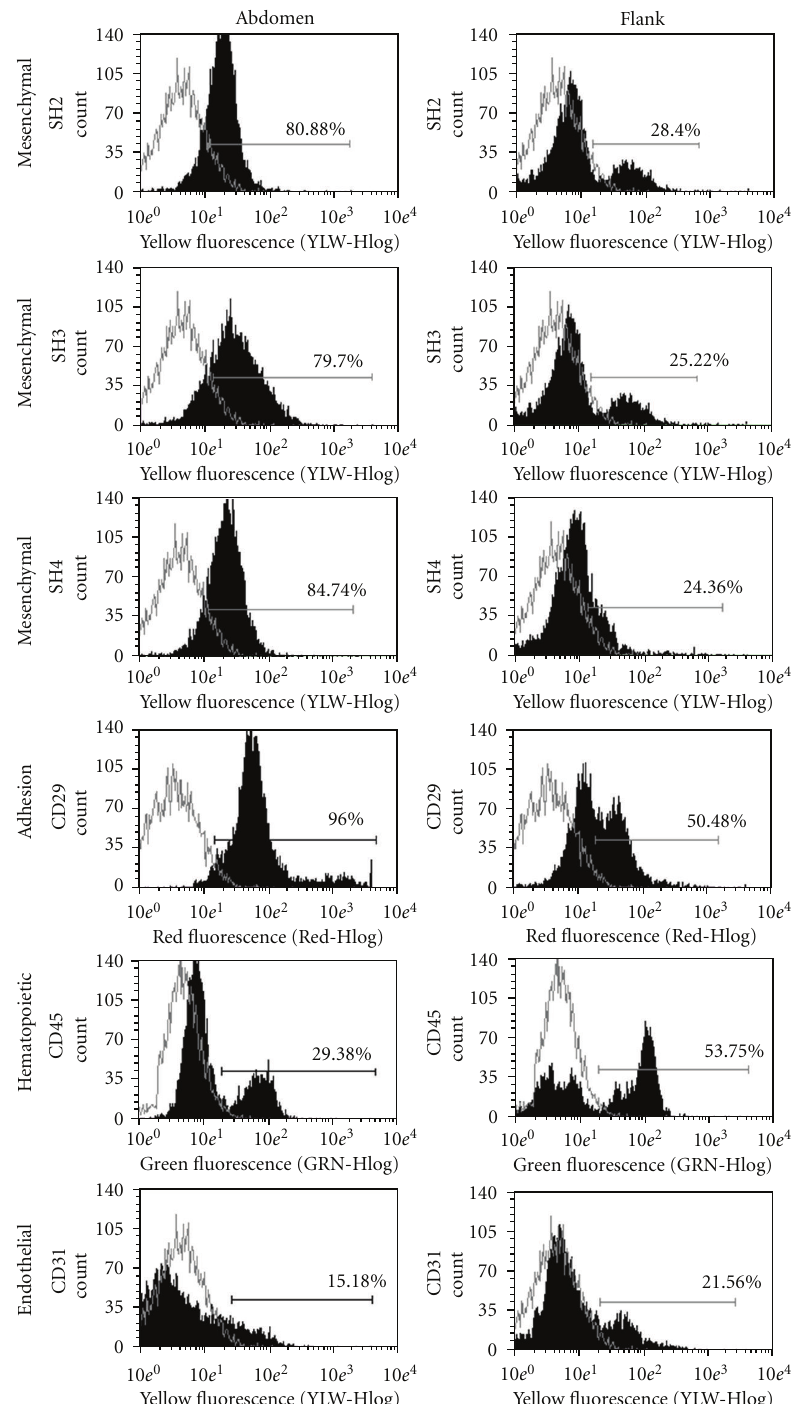
Figure 4: Immunophenotype characterization of fresh human stromal vascular fraction isolated from adipose tissue. The donors were submitted to liposuction in 2 di ff erent sites (abdomen and flank), and each sample analyzed is a pool of the stromal-vascular fraction from five women donors. Histogram for each sample (areas displayed in black) comparing cell number and fluorescence intensity with matched negative controls (areas displayed in grey). The percentage of positively stained cells is showed above each